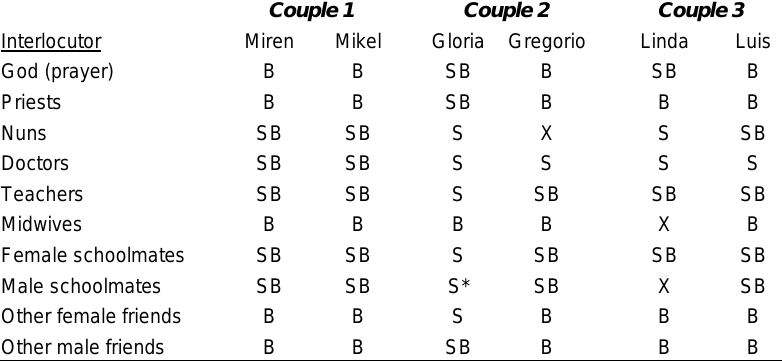
Couple 1 Couple 2 Couple 3